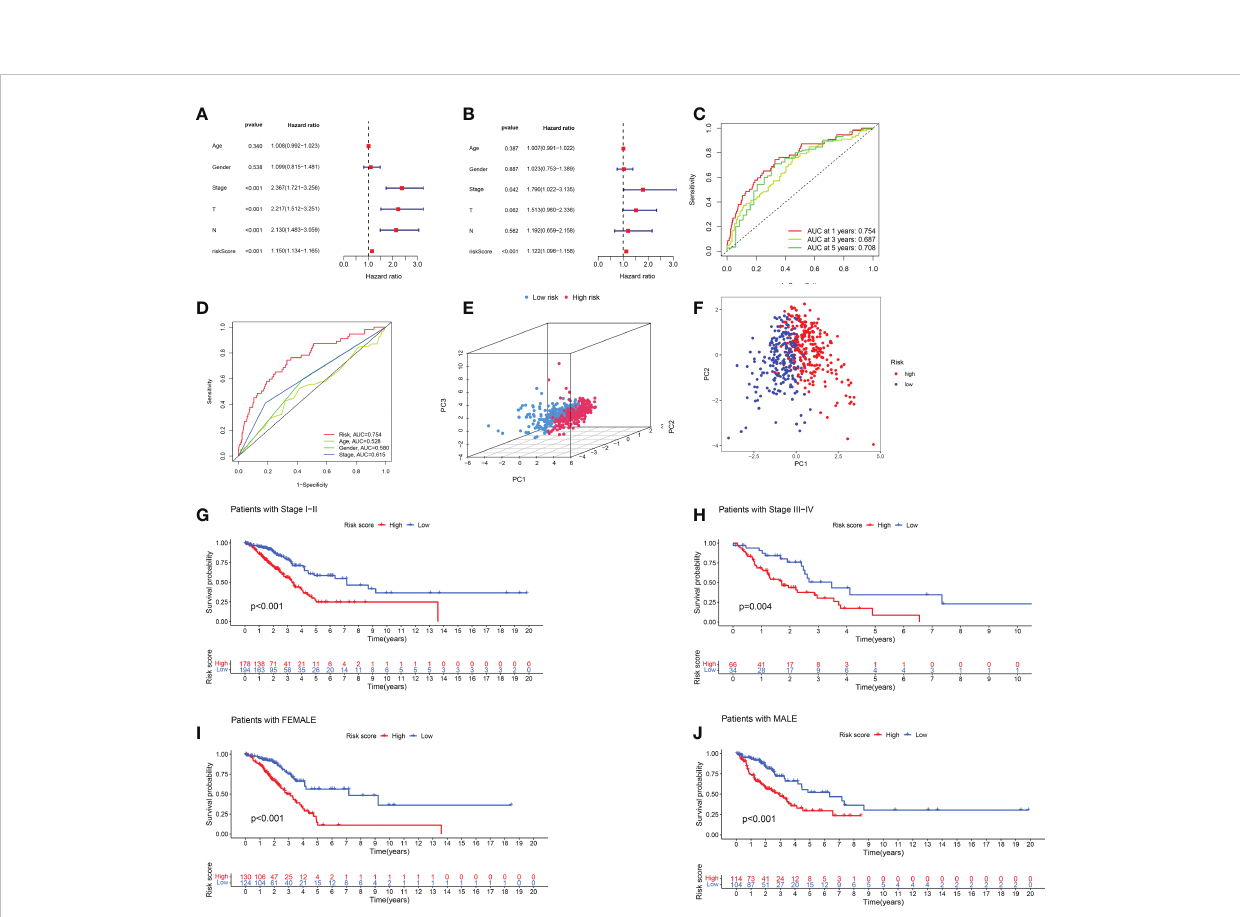
FIGURE 4 Validation of prognostic models for lncRNAs associated with histone acetylation modi fi cation. (A, B) A multivariate and univariate analysis of clinicopathological factors associated with OS in patients with LUAD. (C) One-, three-, and fi ve-year OS prediction models (D) Risk scores and other clinical factors are compared using ROC curves. (E, F) PCA analysis of risk model based on expression pro fi les of 7 HARlncRNAs. (G, H) Strati fi ed survival analysis based on clinical stages of LUAD. (I, J) Strati fi ed survival analysis based on patient